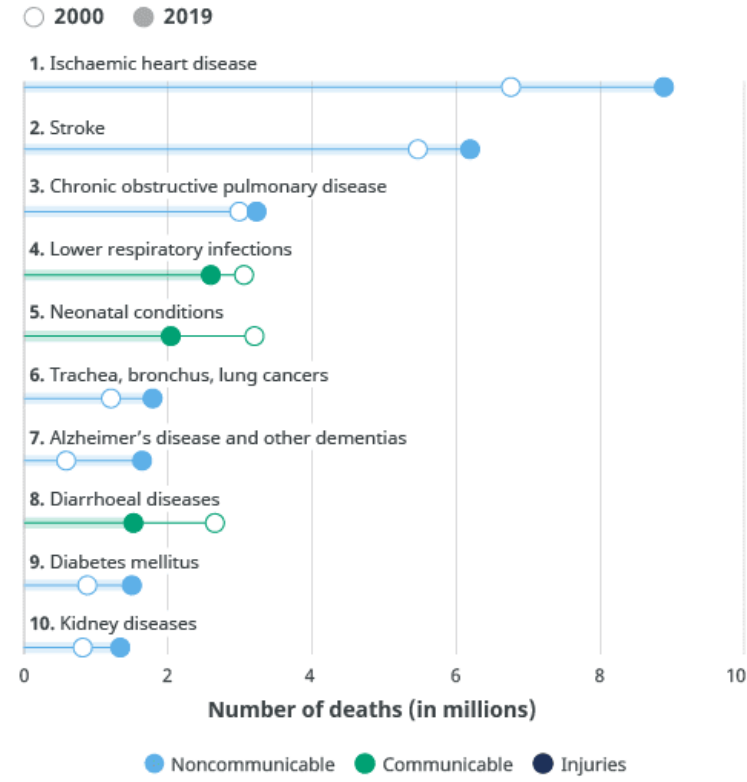
Figure 1. Chronic diseases causing death—top 10 global causes of death, 2016 [16].